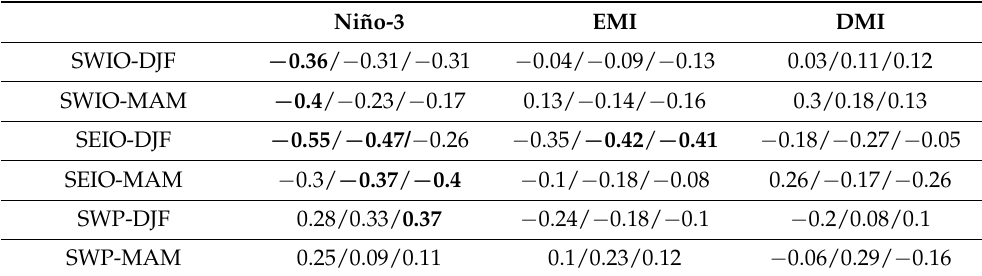
Table 2. Lead-lag correlation coefficients between TCF anomalies and each climate indices. Left/middle/right values indicate DJF/SON/JJA (MAM/DJF/SON) coefficients during DJF (MAM) TCF cases. Bold indicates above 90%